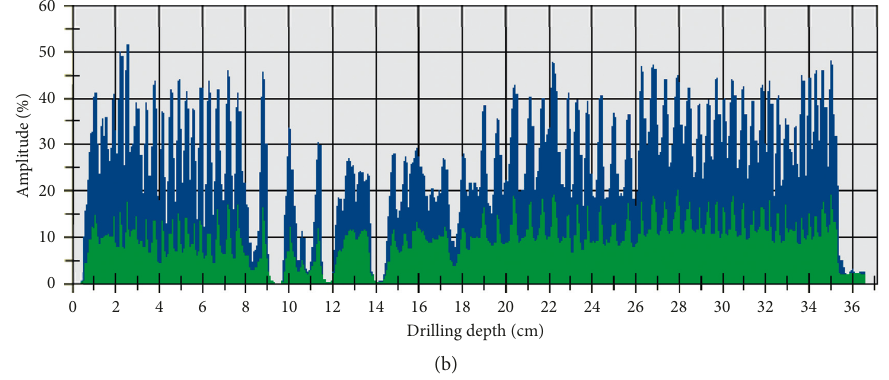
Figure 16: Detection image: (a) stress wave detection; (b) drilling resistance